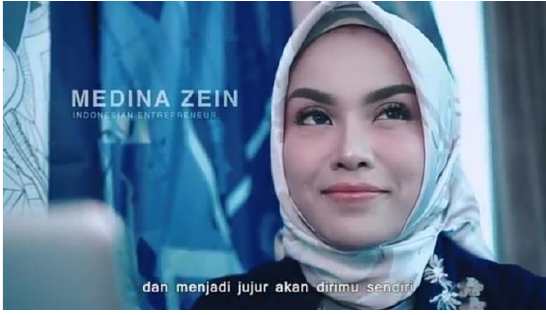
Figure 14: An Honest Muslim Woman